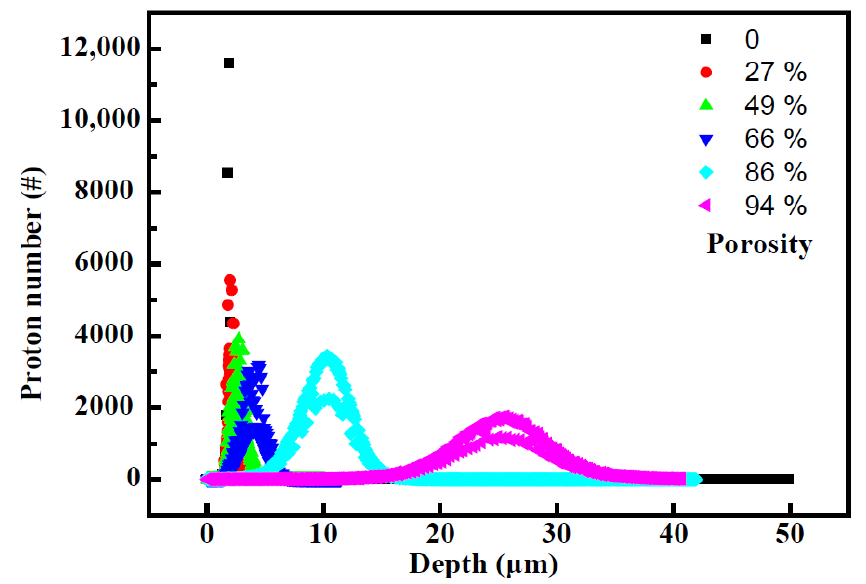
Figure 5. The relationship between porosity and proton distribution (the voids were set as a 100 nm cube, and the distance between the adjacent voids was set as 102 nm, 105 nm, 115 nm, 126.6 nm and 155 nm, respectively).